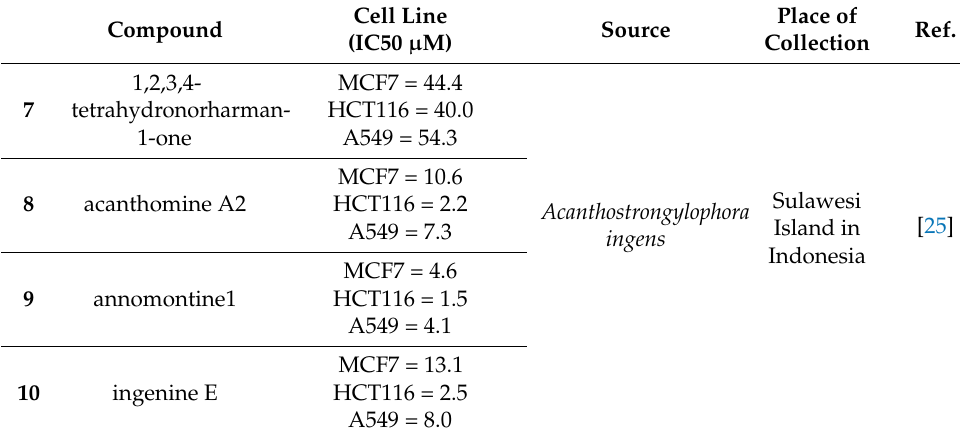
Table 2. Cytotoxic activity of β -carboline